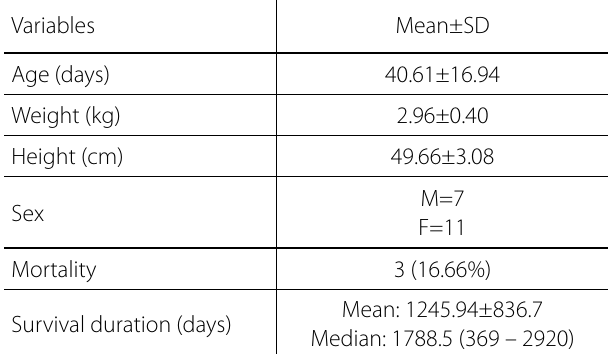
Table 3. Demographic details and surgical outcomes of patients with intramural coronary artery.